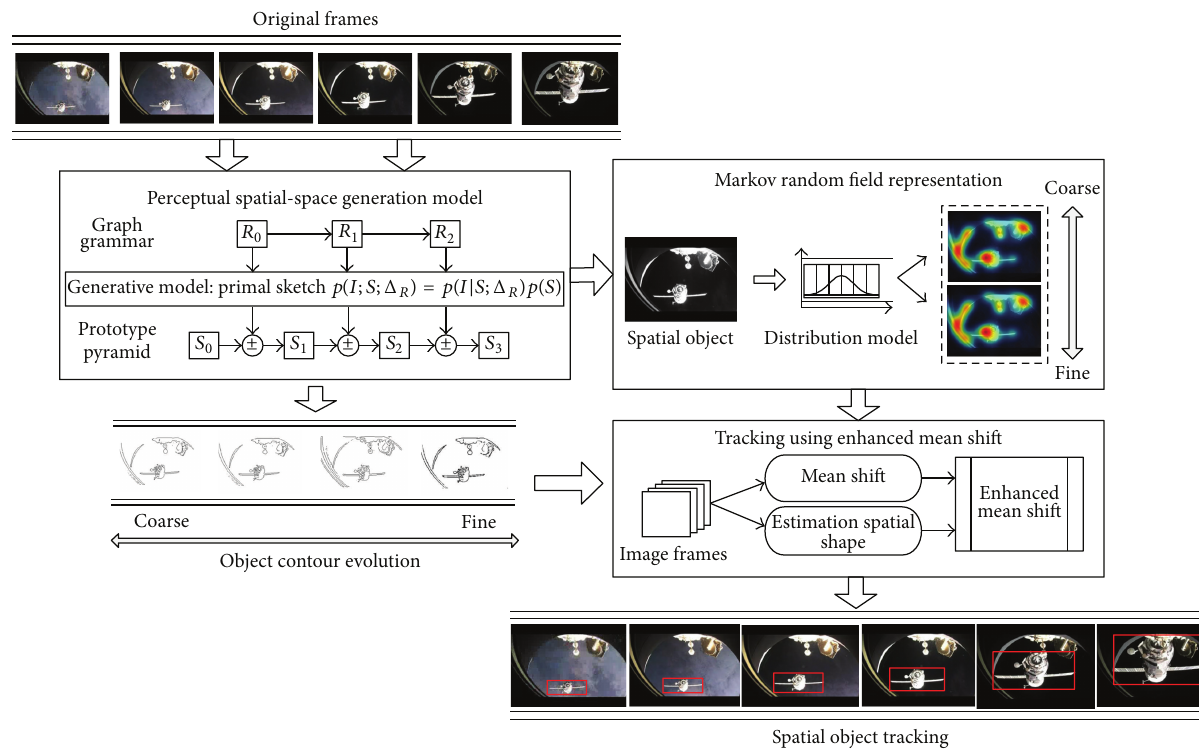
Figure 1: Enhanced mean shift method based on a perceptual spatial-space generation